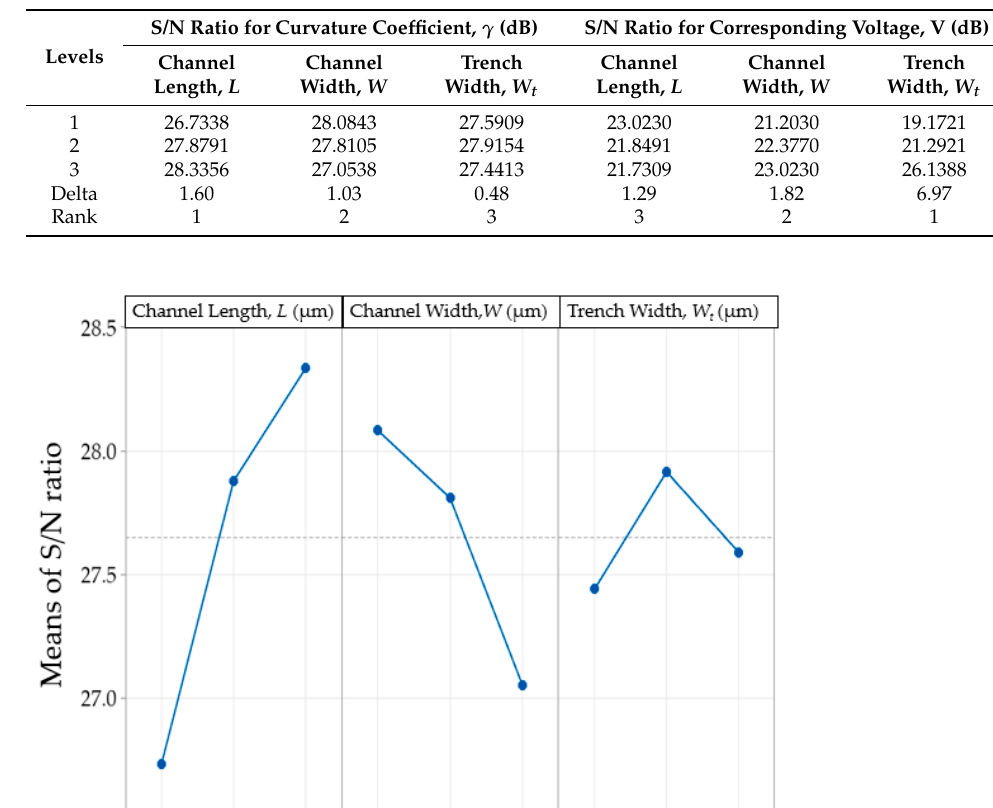
Figure 5. Plot of main effects of S/N ratio for γ .